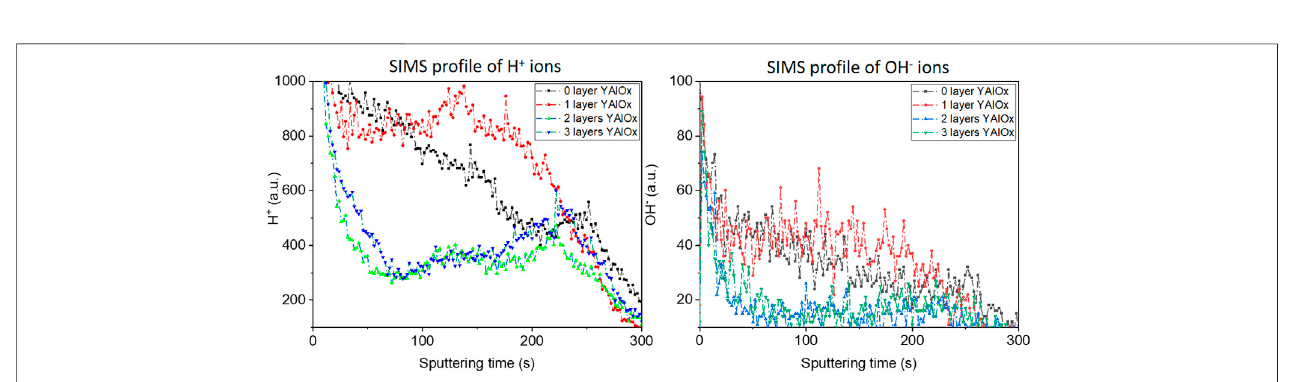
FIGURE 6 | Comparison of SIMS pro fi les of H + and OH − through the depth of the bilayer dielectrics.